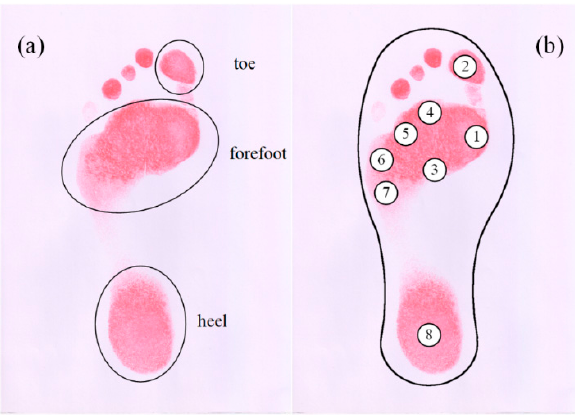
Figure 6. ( a ) Footprint of a bare foot; ( b ) the targeted locations for arranging sensing elements.